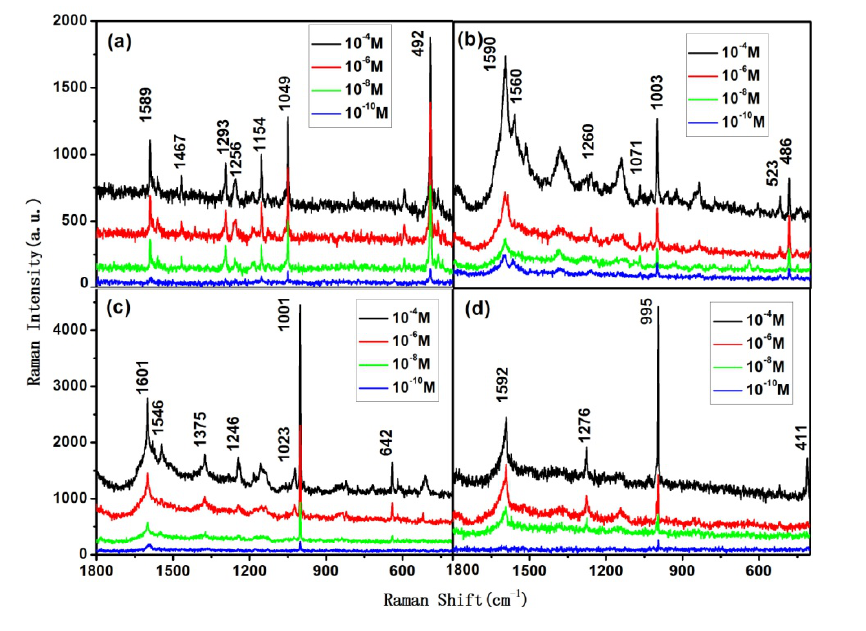
Figure 4. SERS spectra of tetrachlorobiphenyls at concentrations from 10 - 4 to 10 - 10